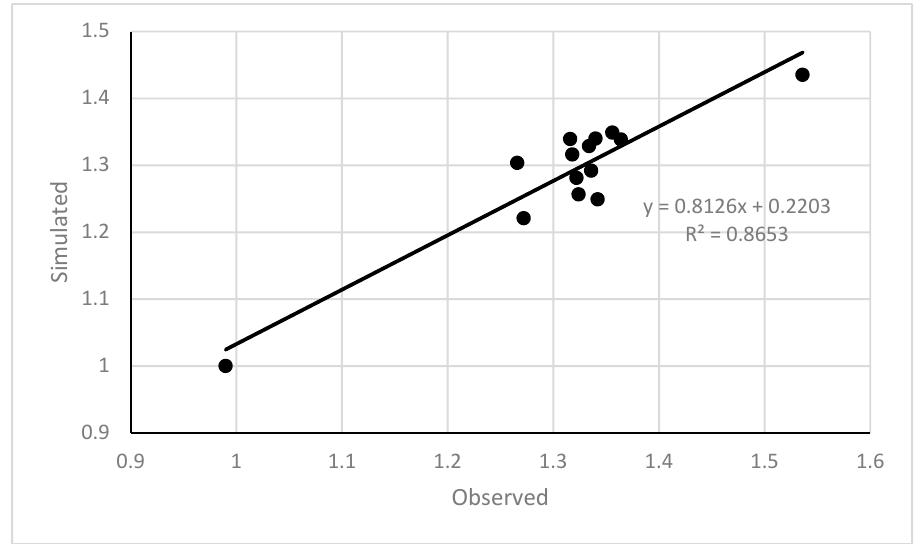
Figure 6. The relationship between the observed and modeled salinities at sites 1 to 14 (see Figure 1).